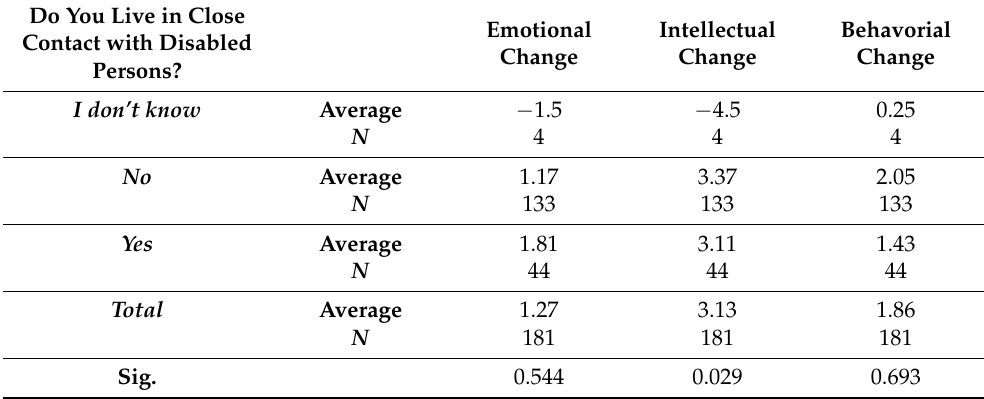
Table 8. Examination of students with respect to contact with disabled